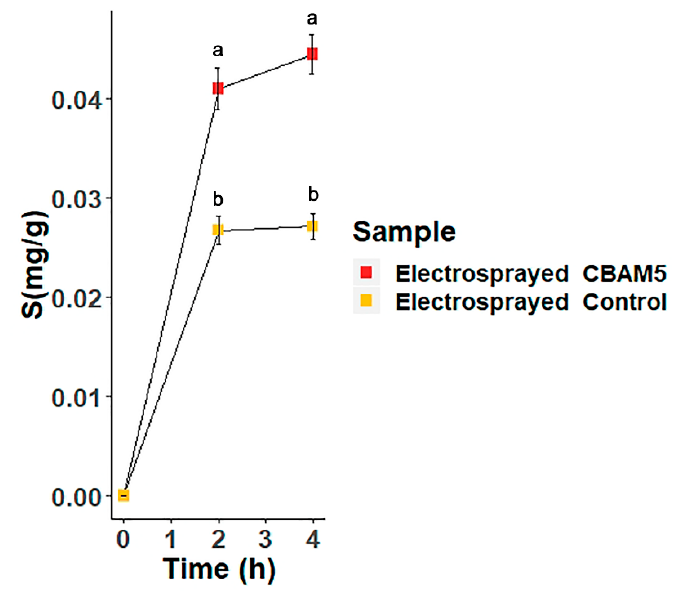
Figure 6. Gold Biosorption assay with L. sphaericus CBAM5 encapsulated in microcapsules of alginate (Electrosprayed CBAM5) and with microcapsules free of bacteria (Electrosprayed Control) for 4 h. Points at 2 and 4 h denoted by a different letter differ significantly at p < 0.05 according to a Student’s t-test analysis.